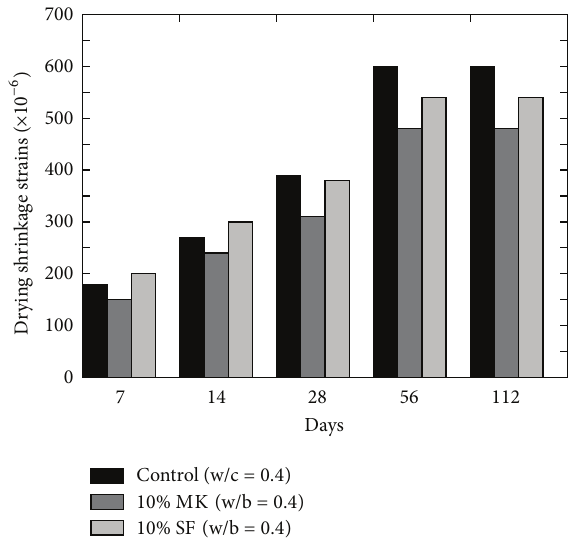
Figure 5: Effect of cement replacement content on the creep strain of SF concrete (at w / b = 0.35 ) [29]. Figure 6: Comparison of MK and SF concretes against drying shrinkage [30].